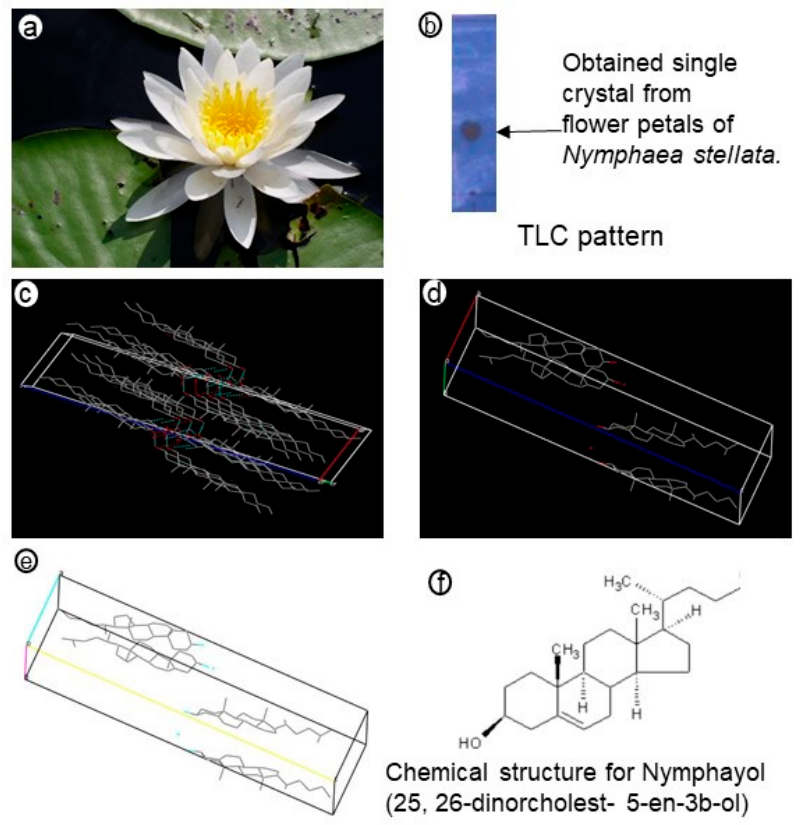
Figure 1. Nymphaea stellata flower petals ( a ) and thin layer chromatography (TLC) single spot of isolated crystal from the chloroform extract ( b ); ( c – e ) shows that the crystal structure refinement for the asymmetric unit consists of two molecules of 17-(hexan-2-yl)-10,13-dimethylhexadecahydro-1 H - cyclopenta[ a ]phenanthren-3-ol and one water molecule; ( f ) shows the structure of the novel compound, 25,26-dinorcholest-5-en-3b-ol. The isolated novel crystal was named nymphayol.